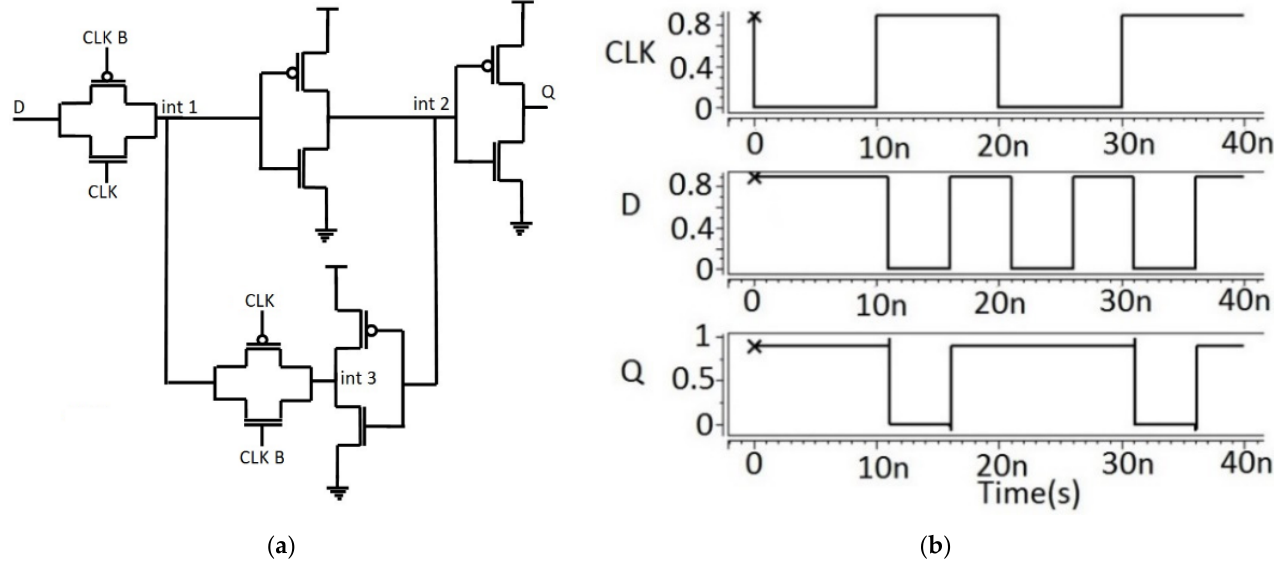
Figure 1. ( a ) Static D-latch schematic; ( b ) input and output signals of the Static D-latch.